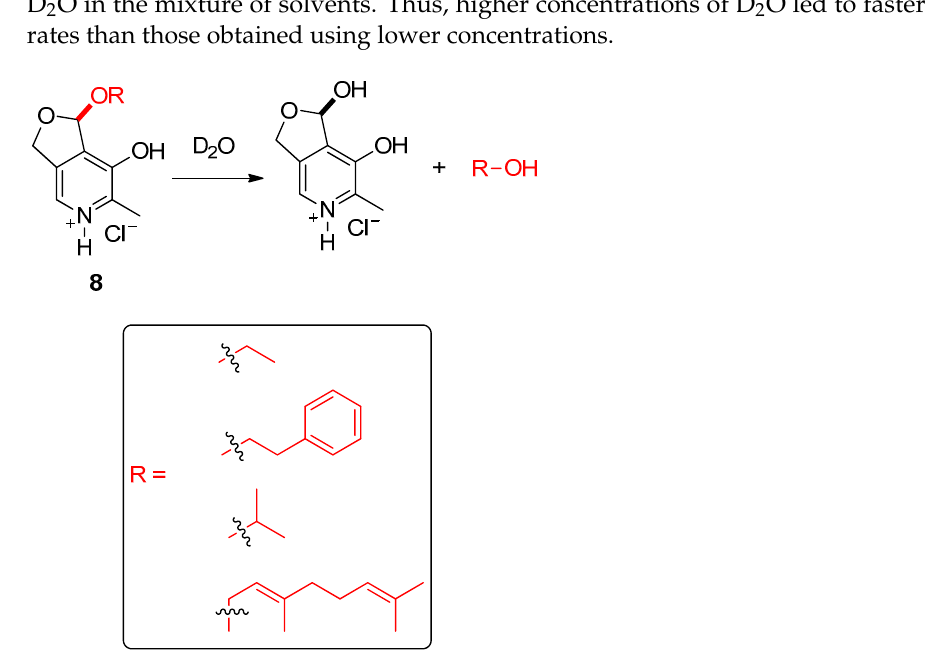
Figure 10. Water-triggered release of alcohol-based scents from pyridoxal acetal profragrances 8 , highlighting the precursor of the alcohol scent and showing the fragments of the scents include in a box. The original results were reported by Boyce and coworkers [91].